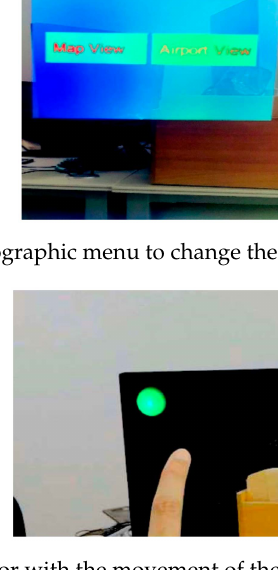
Figure 6. Moving green cursor with the movement of the hand to interact with the